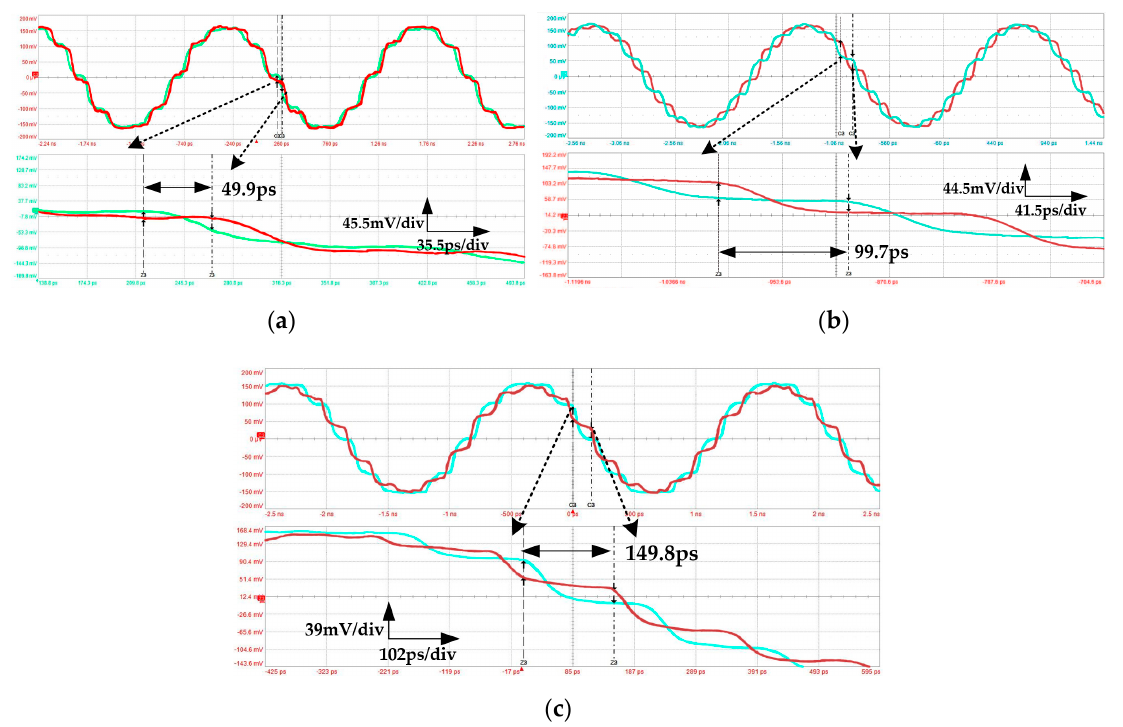
Figure 12. Four-channel output waves with 500 MHz input sampled at 4 × 5 GS/s. ( a ) Output of channel A and channel B with 0.1ps phase error; ( b ) output of channel A and channel C, indicating 0.3 ps phase error between channels A and C; ( c ) output of channel A and channel D, indicating 0.2 ps phase error between channels A and D. As a result, the standard deviation of the timing mismatch is 0.118 ps, satisfying the requirement of 6-bit resolution.